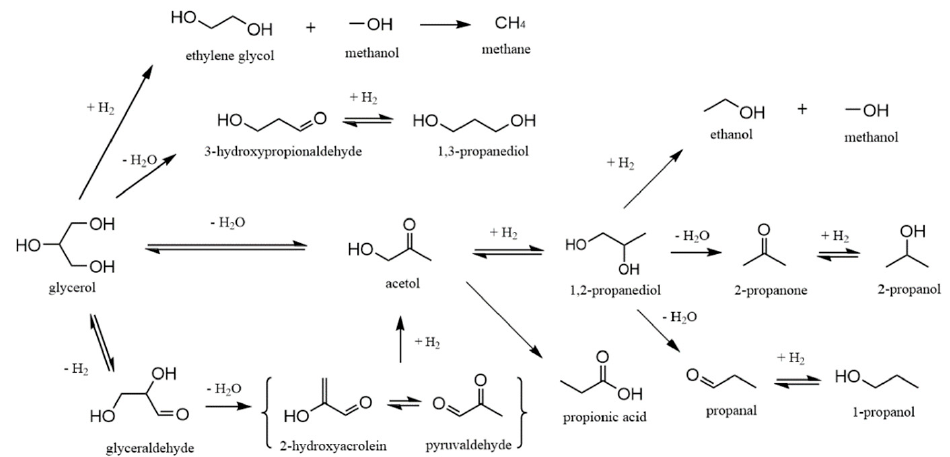
Figure 2. Comprehensive reaction network for glycerol hydrogenolysis.